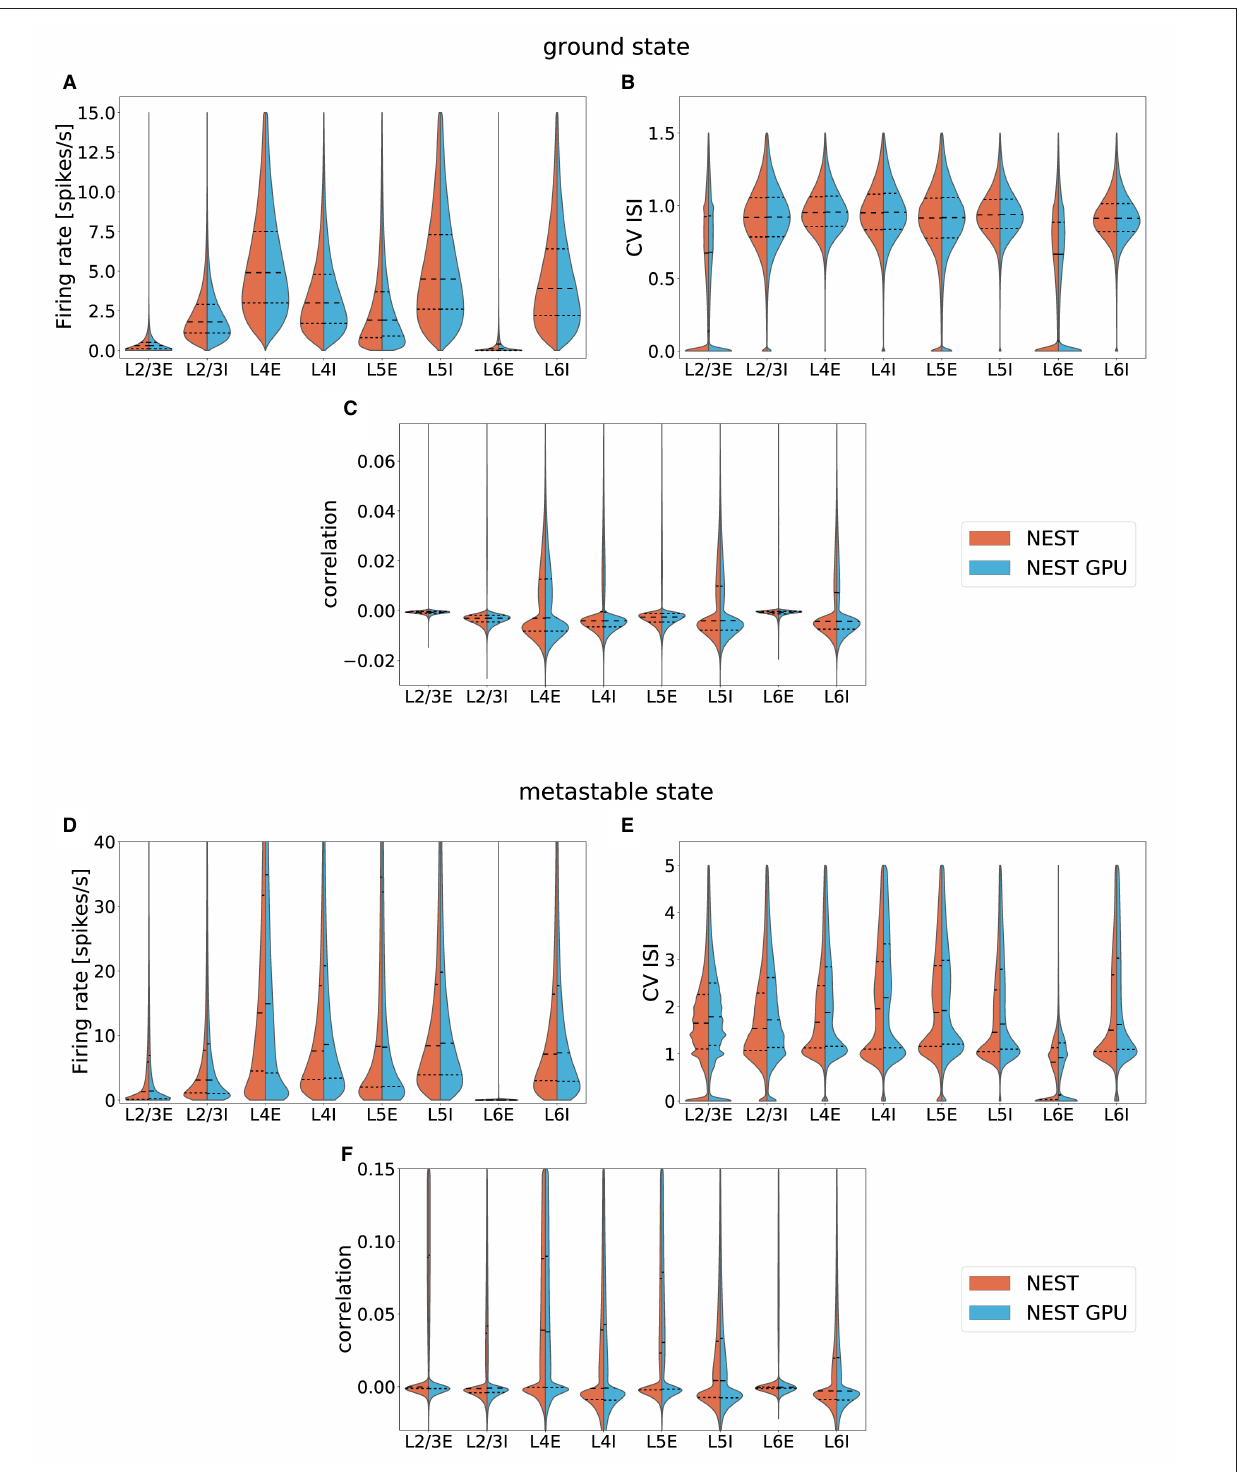
FIGURE 5 | Averaged distributions of the ground state and the metastable state of the model for all 32 areas obtained using NEST (orange, left side) and NEST GPU (sky blue, right side) and compared with split violin plots. The central dashed line represents the distribution’s median, whereas the other two dashed lines represent the interquartile range. (A,D) average firing rate, (B,E) average CV ISI, (C,F) average Pearson correlation of the spike